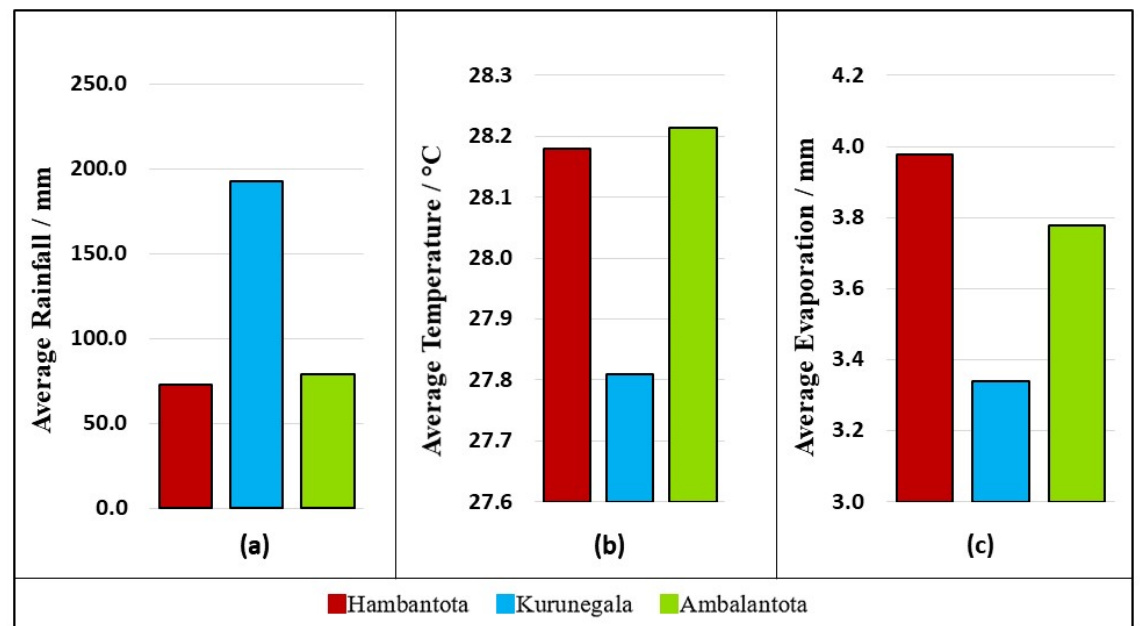
Figure 6: Analysis of climatic data (a) Average rainfall (b) Average Temperature (c) Average evaporation of Hambantota, Kurunegala and Ambalantota locations.